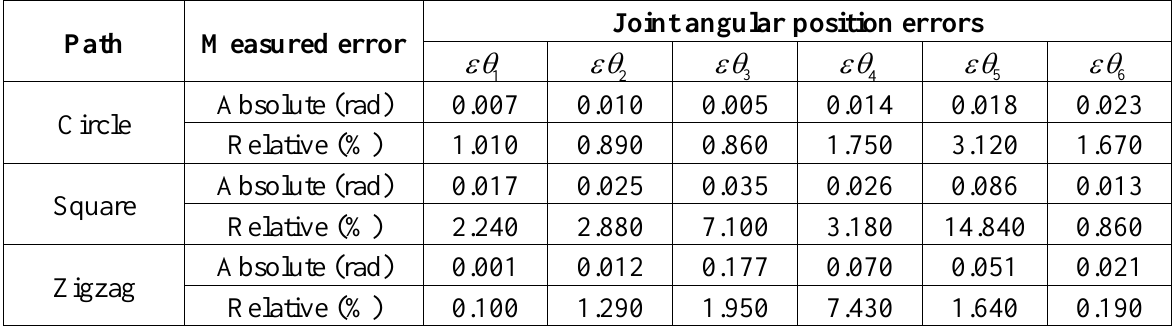
Table 4. Measured angular position errors for each joint, for a circle and a square